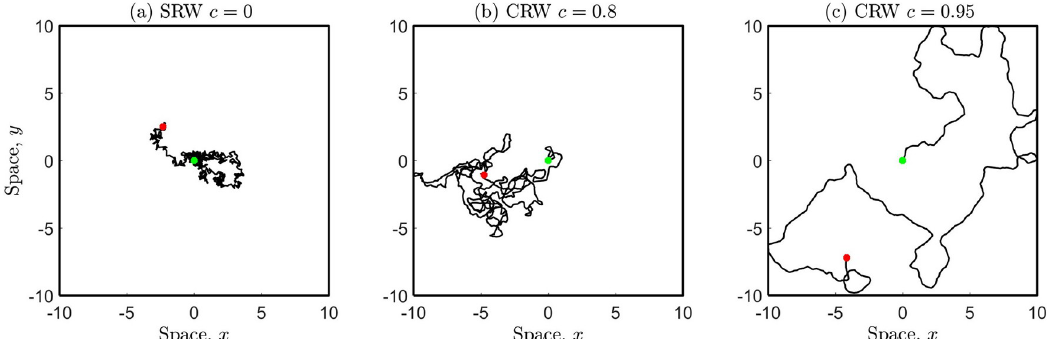
Fig 1. Individual movement paths for the CRW with mobility parameter σ = 0.1. (a) SRW c = 0 (special case) and (b) CRW c = 0.8, (c) CRW c = 0.95. Each individual has starting location at (0, 0) (green marker) and executes n = 1000 steps, corresponding to time t = 25 using a time increment of Δ t =